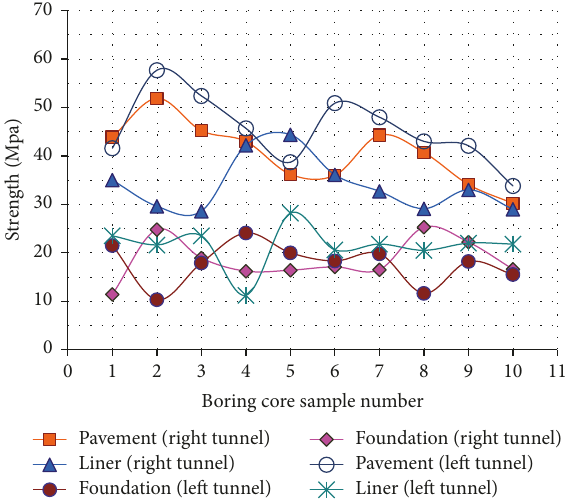
Figure 9: Structural strength detection